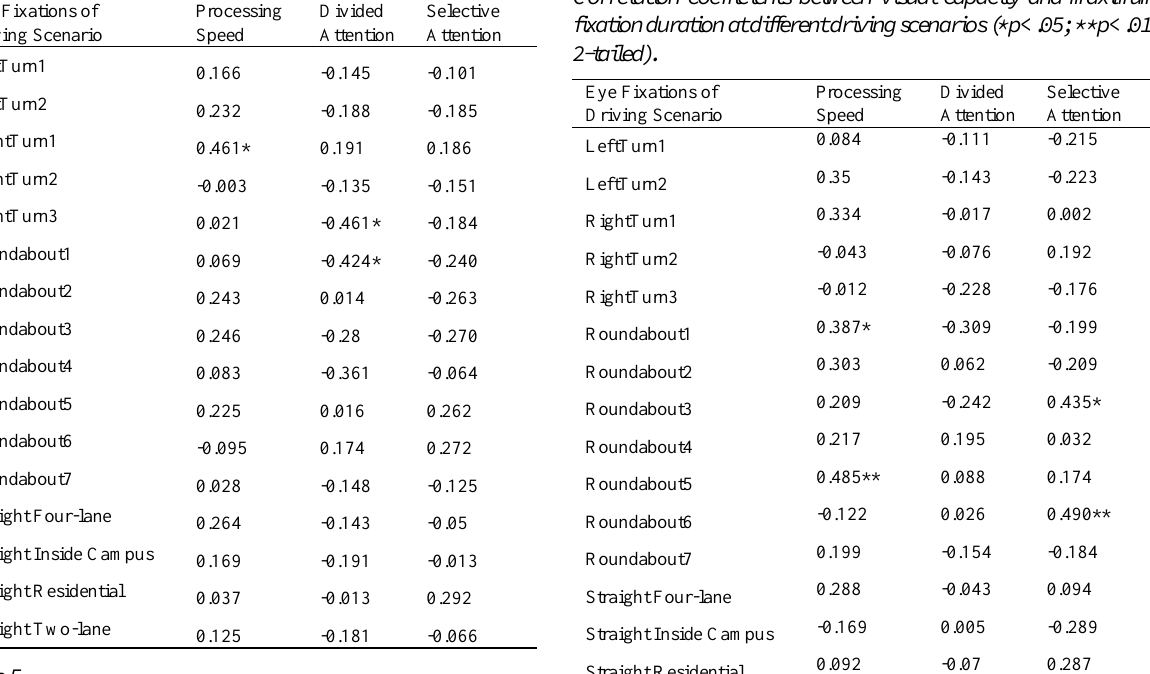
Correlation coefficients between visual capacity and standard